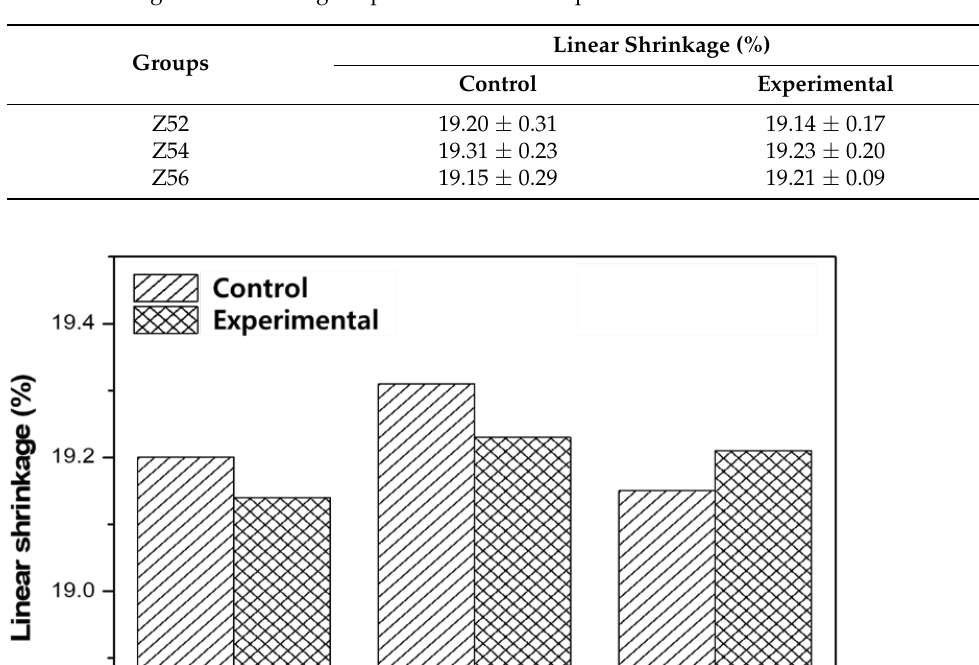
Table 3. Relative density of printed zirconia; different letters represent significant differences ( p < 0.05).